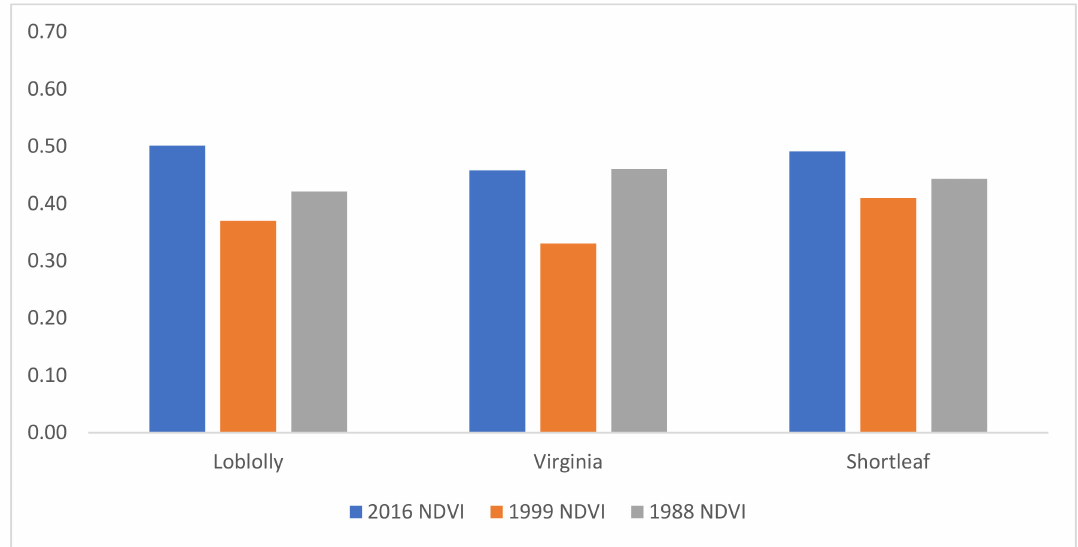
Figure 9. Mean NDVI ± standard deviation (SD) of southern yellow pines (loblolly, Virginia and shortleaf pines) for December 1988, November 1999 and February 2016. Error bars represent SD of the